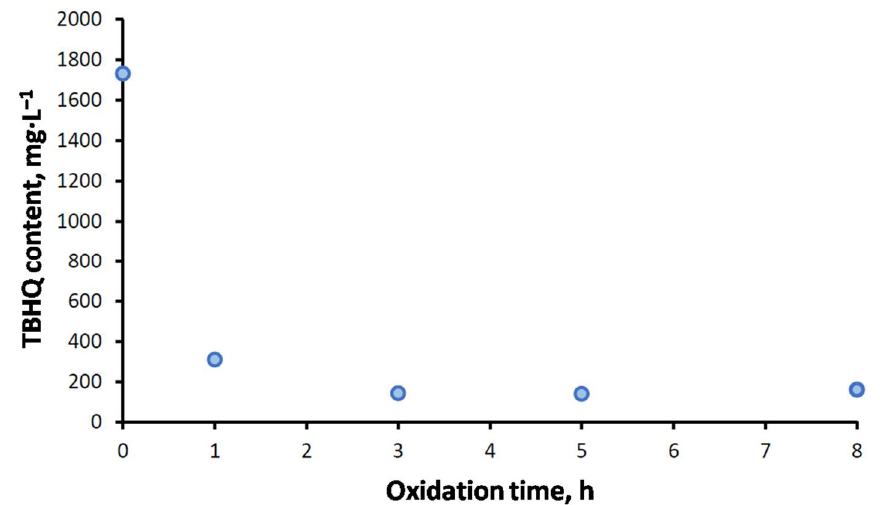
Figure 17. Effect of extreme oxidation on TBHQ content in FOBL. Table 6. TBHQ quantification during extreme oxidation of FOBL (Op. TBHQ).